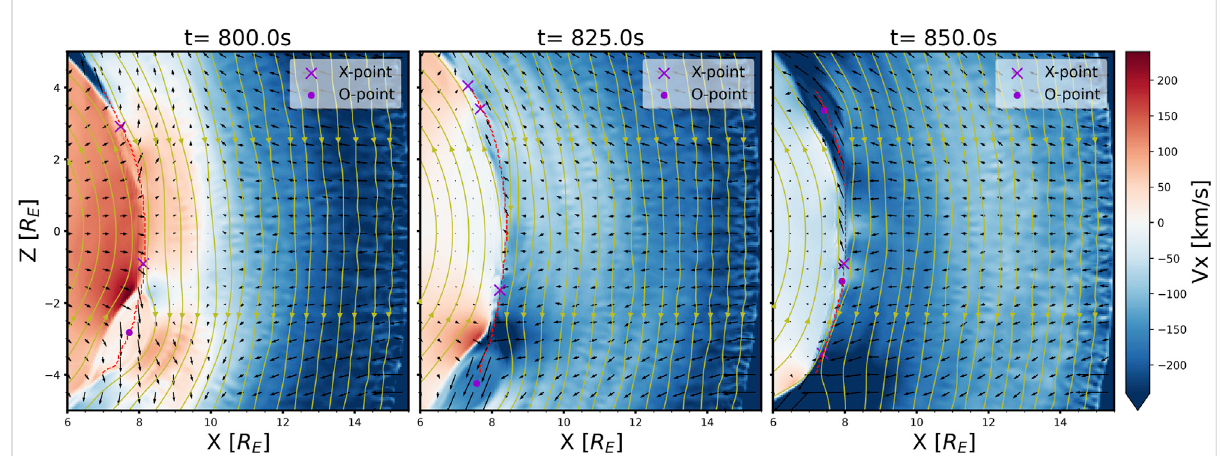
FIGURE 8 Filled contours of bulk velocity V x , with in-plane velocity quivers in black and magnetic fi eld lines in olive. The red dotted lines denote the magnetopausewhere B z =0.ThevioletcrossesanddotsdenotecomputedX-pointsandO-pointsfromthemagnetic fl uxfunction,respectively.The three snapshots at t = 800s, 825s, and 850s represent the transition from expansion phase to compression phase of the